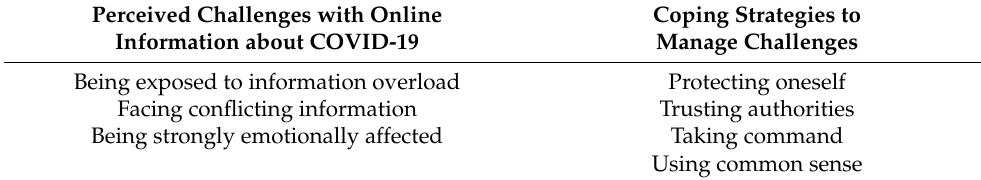
Table 2. Domains and